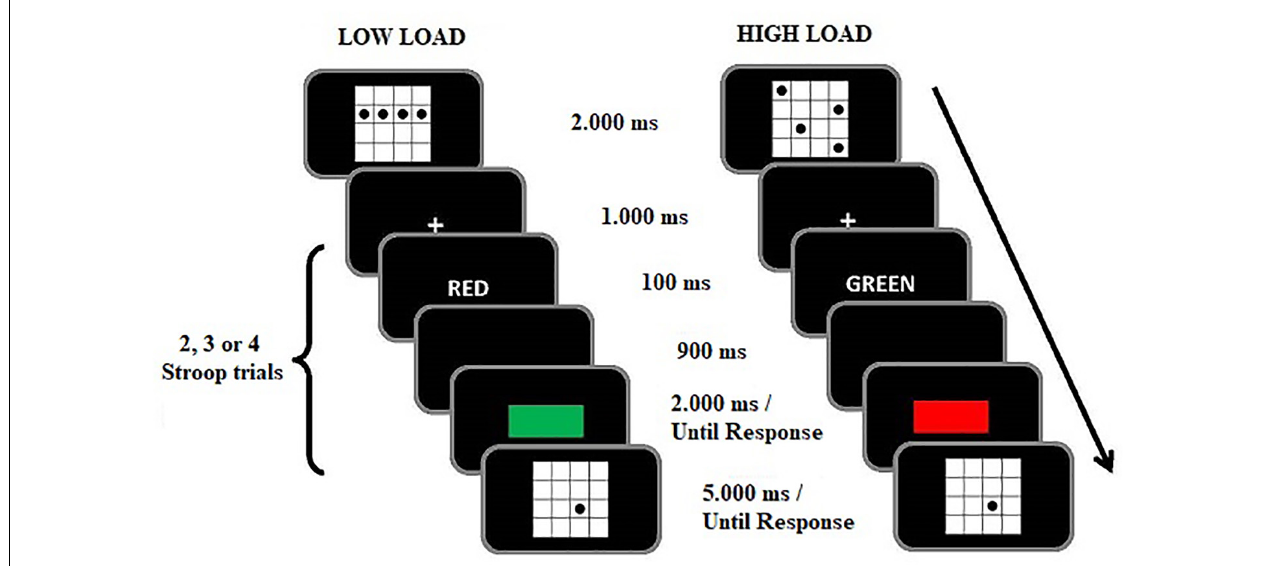
FIGURE 5 | Examples of trials under low (Left) and high (Right) load in the spatial working memory task in Experiment 2.